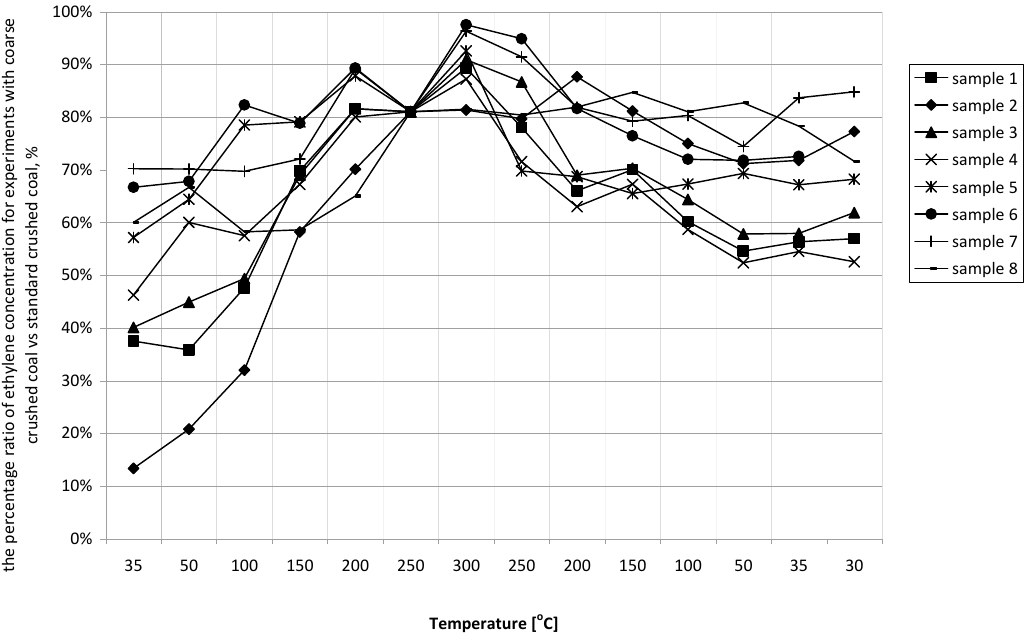
Figure 4. The course of changes in the ratio of emitted ethylene (coarse vs. standard coal crushing) in the stage of heating and cooling of coal samples.